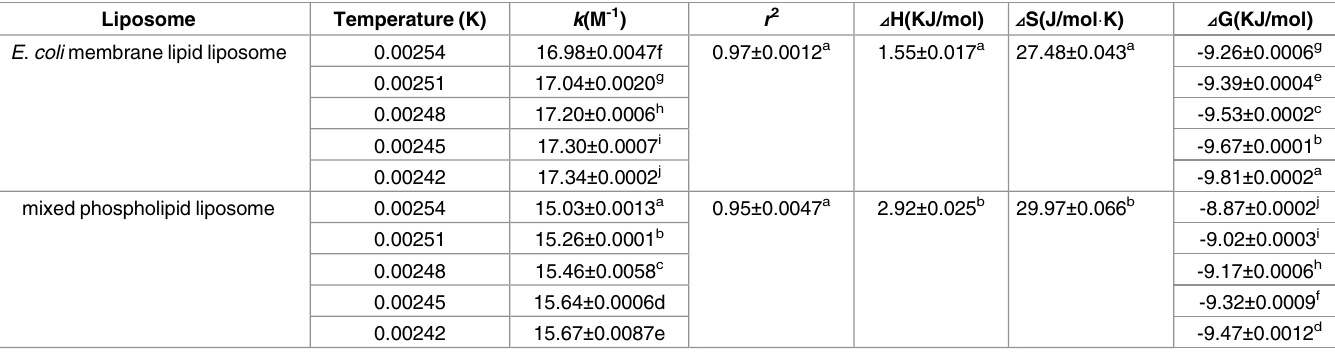
Table 2. The thermodynamic parameters of Apep10 interacting with E . coli membranelipid liposome and mixed phospholipid liposome. Liposome Temperature